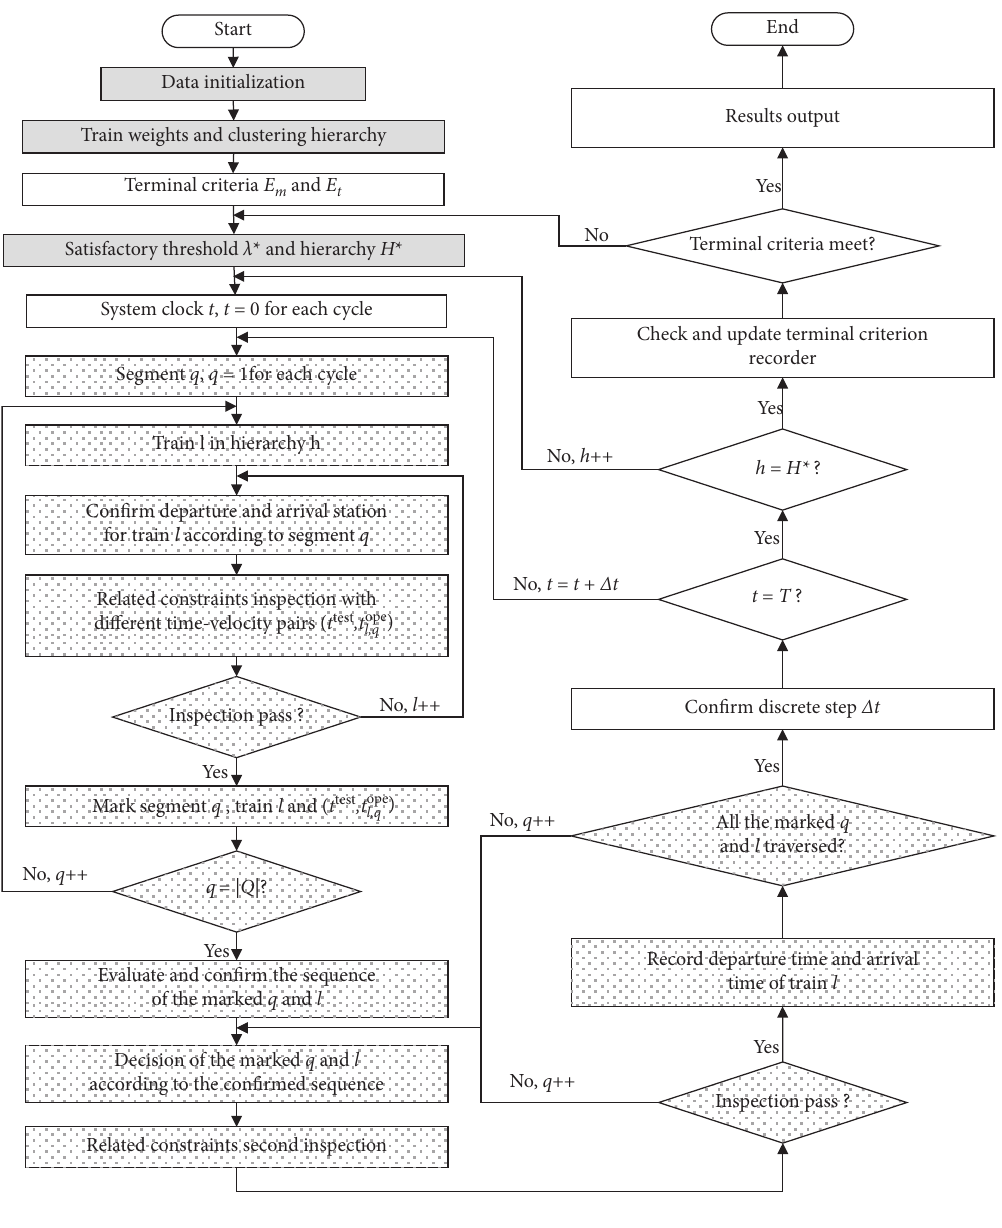
Figure 6: The simulation flowchart of train rescheduling based on